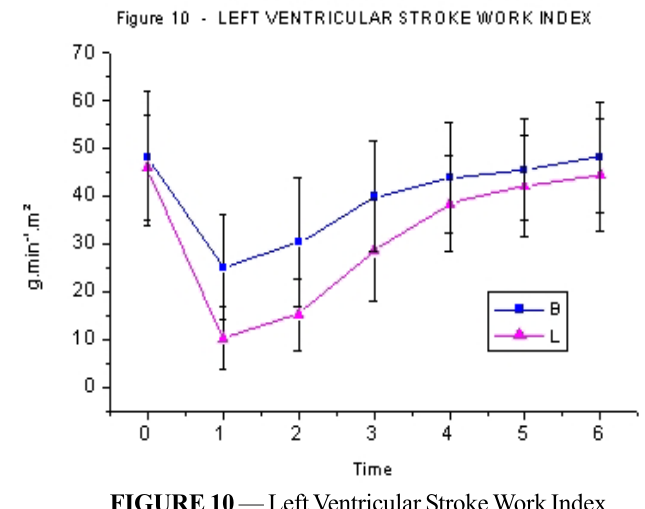
FIGURE 10 — Left Ventricular Stroke Work Index